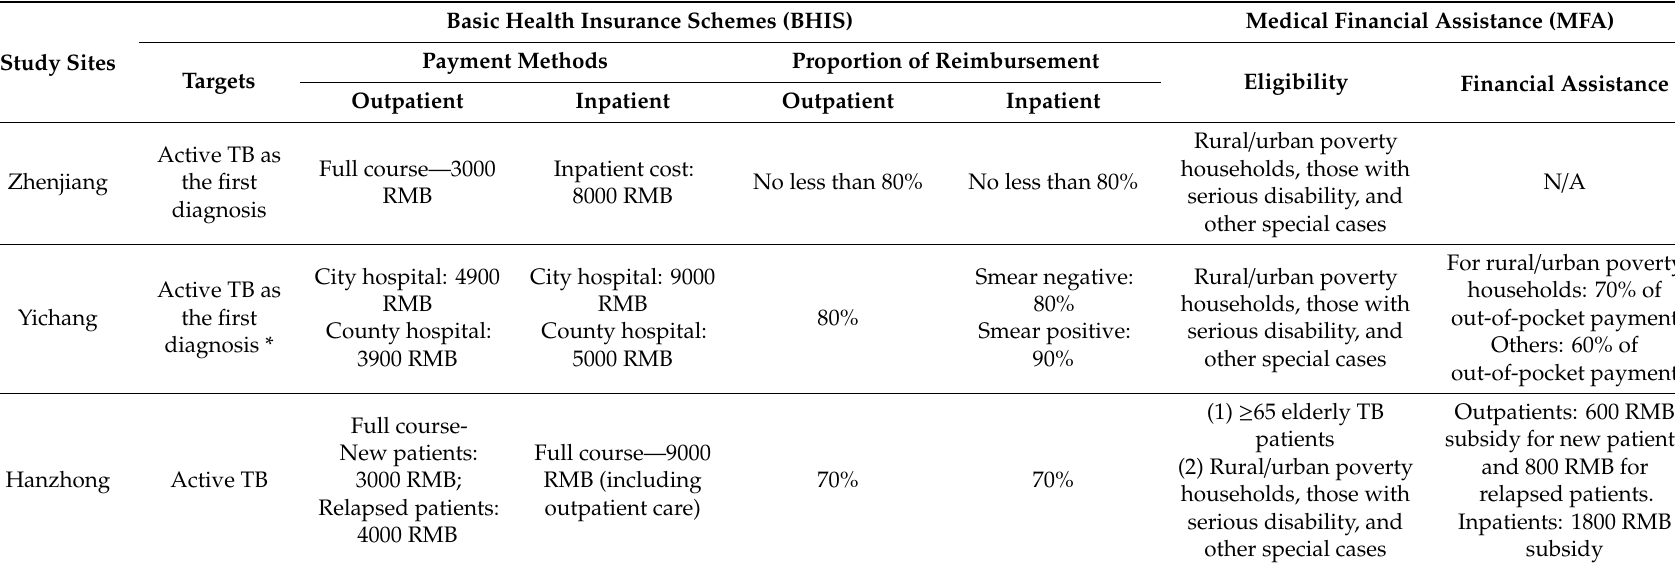
Table 2. Financing and payment policies for tuberculosis (TB) treatment in designated hospitals in three prefectural cities.